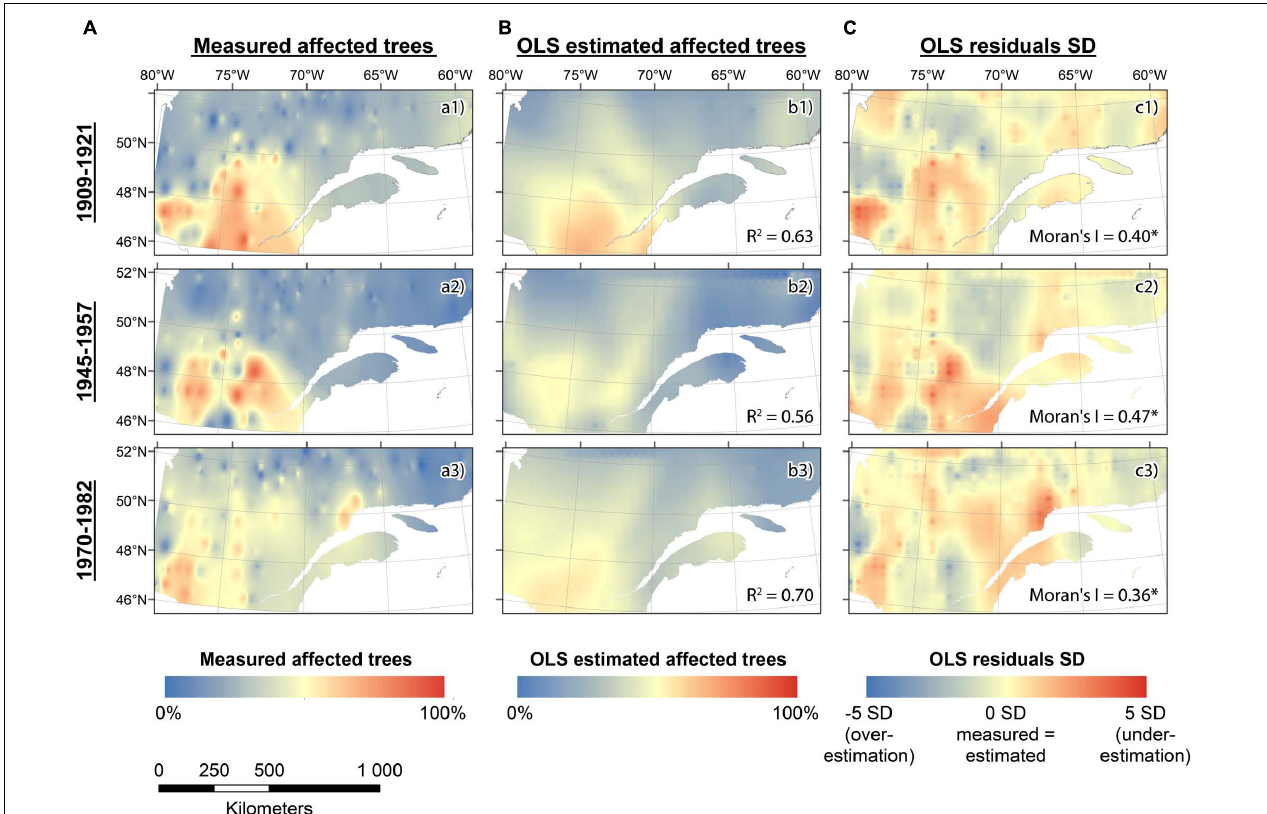
FIGURE 6 | Ordinary Least Squares (OLS) model for each outbreak period. (A) Average measured percentage of affected trees over an outbreak period. (B) OLS estimated percentage of affected trees over an outbreak period using seasonal precipitation and temperature as explanatory variables according to the Table 2 . (C) Residuals of the OLS